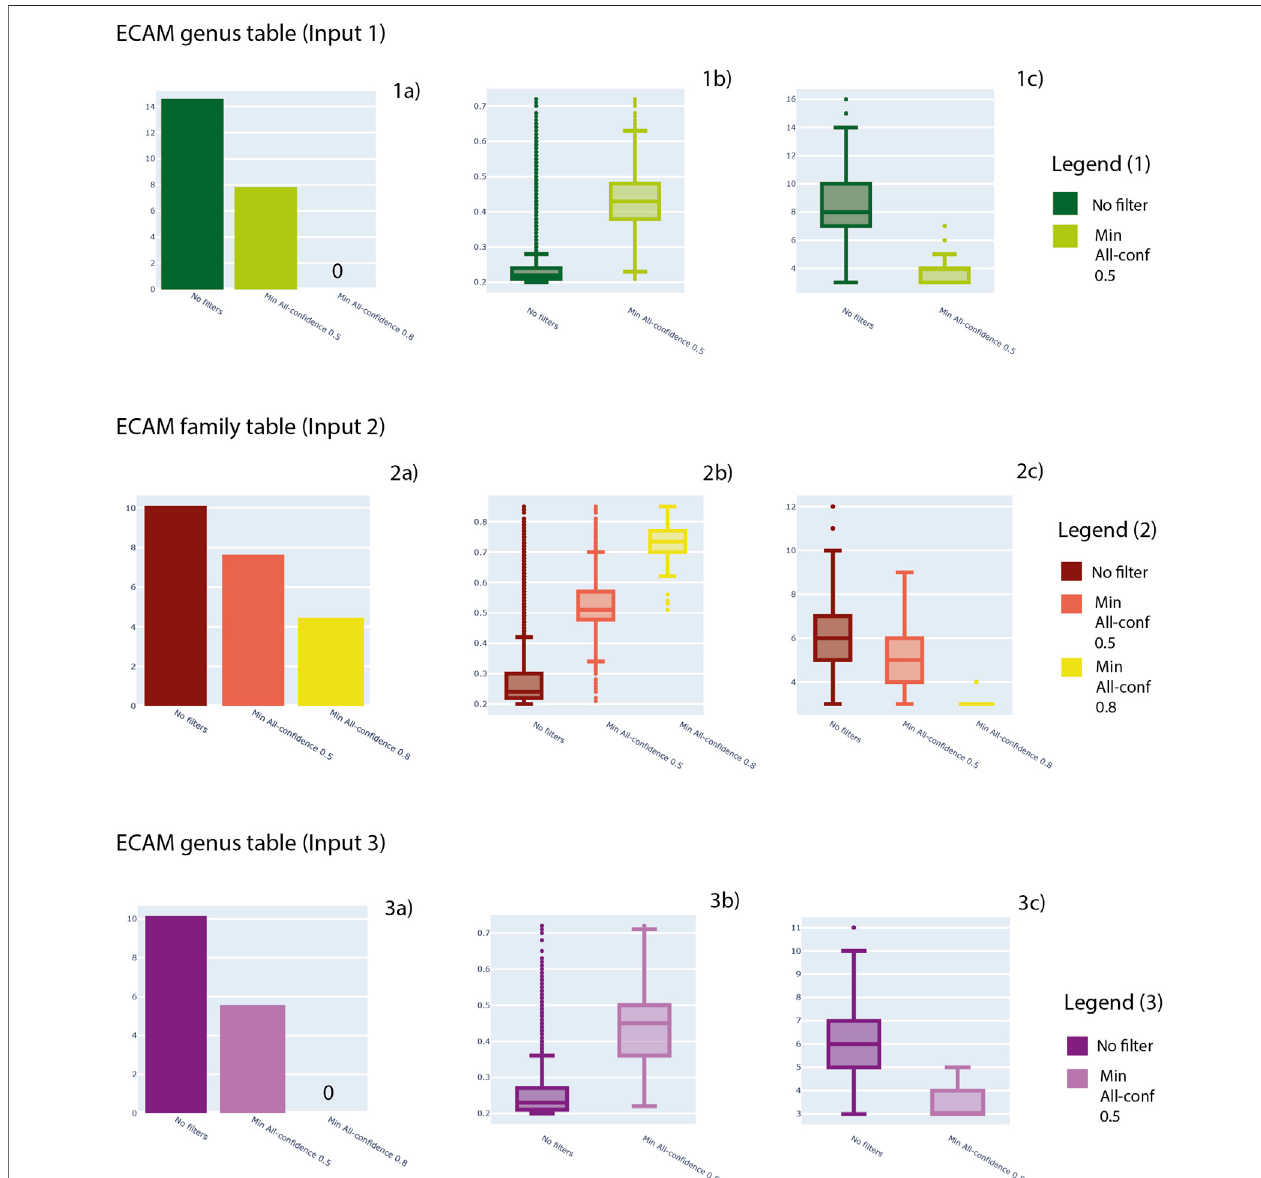
FIGURE4| ForInput1,2and3,herenumberofpatternsobtained(1a,2a,3a),distributionofsupportvalues(1b,2b,3b)anddistributionofpatternlengths(1c,2c, 3c) are shown. In particular, three levels of analysis are shown: no fi lters applied to patterns, a minimum all-con fi dence of 0.5 and a minimum all-con fi dence of 0.8.